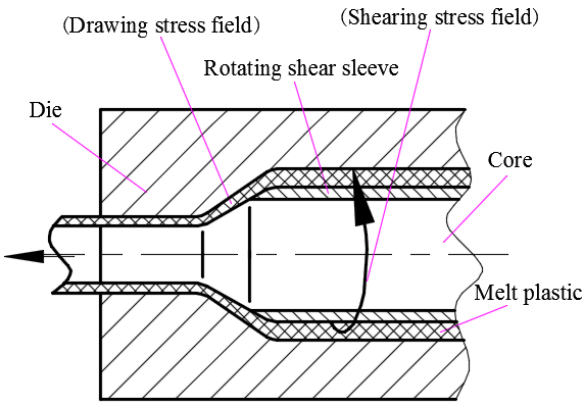
Figure 1. Schematic of the structure and principle of shearing–drawing two-dimensional compound stress field pipe ‐ extrusion.